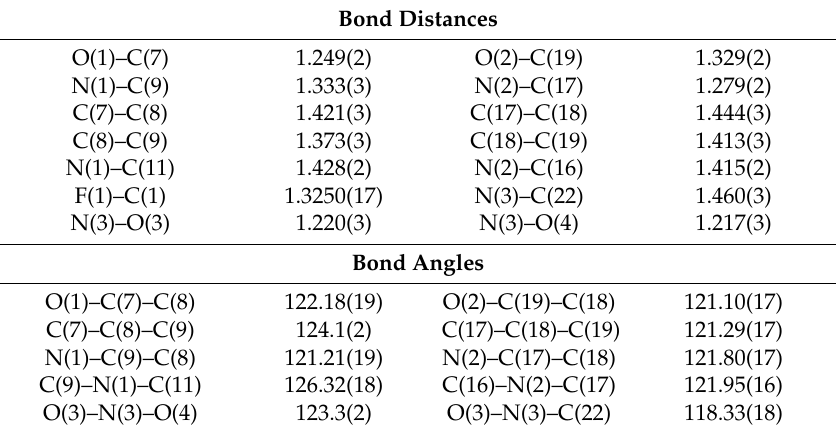
Table 2. Selected bond distances (Å) and angles (°) within the first [Fe(N 2 O 2 )Cl] coordination sphere for compounds 3 ·CH 2 Cl 2 and 5 ·0.5CH 3 CN.